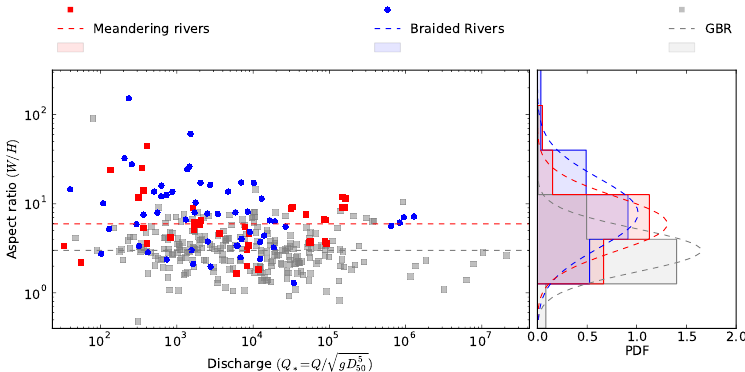
Figure 9. Aspect ratio of braided and meandering threads from Bayanbulak and the GBR data sets, as a function of rescaled water dis- charge ( Q ∗